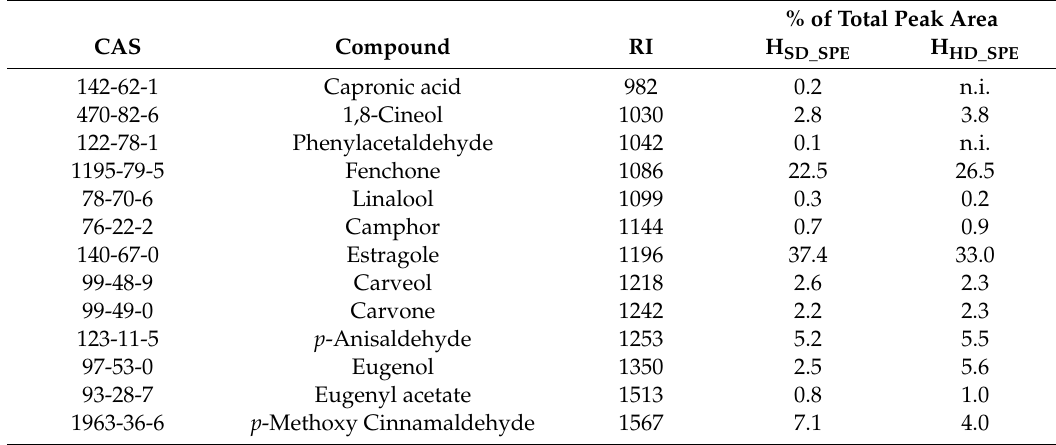
Table 4. List of compounds identified in hydrolate extracts from Foeniculum vulgare Mill.